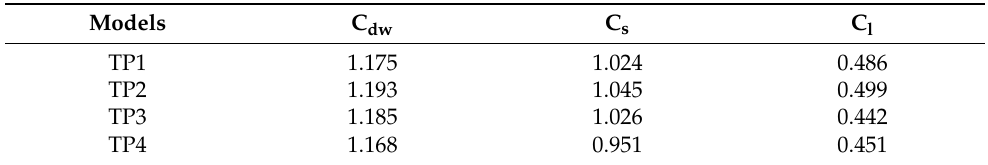
Table 4. Comparison of the time-averaged Cd on the whole train, Cs and Cl of the leading car for the four models. Models C dw C s C l TP1 1.175 1.024 0.486 TP2 1.193 1.045